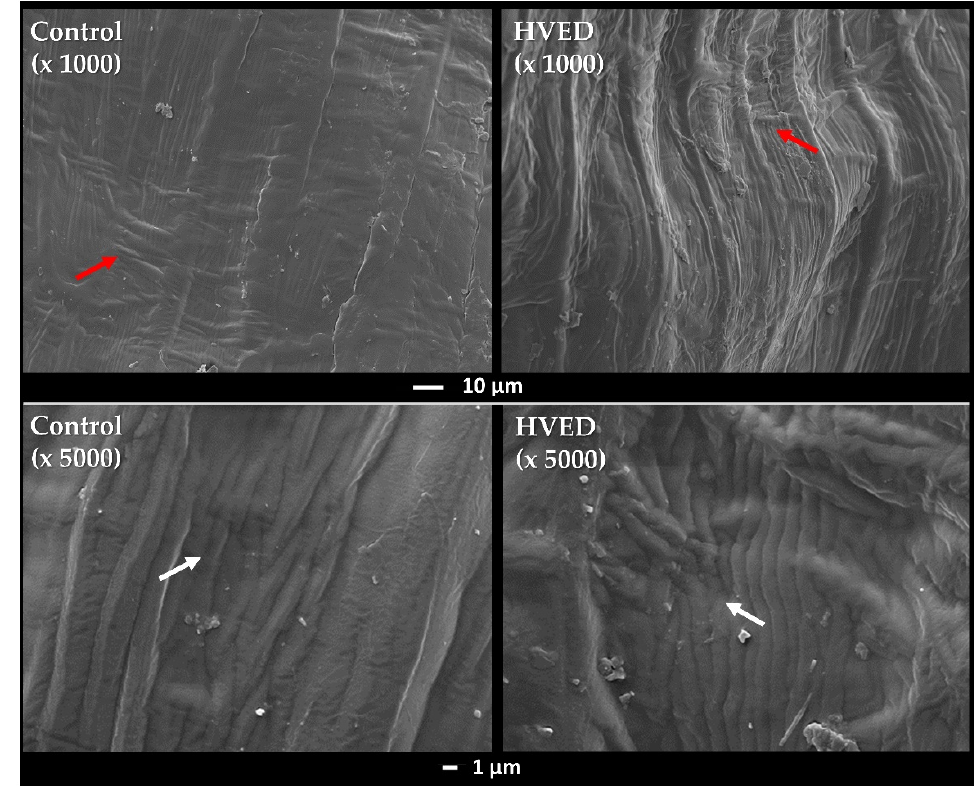
Figure 1. Selected scanning electron microscopy images of the seed morphology recorded at working distance of 10 mm with an acceleration voltage of 5 kV and magnifications of 1000 × and 5000 × . As a result of high voltage electrical discharge treatment (HVED), the number of mesh interconnected structures reduced (red arrows) and the wrinkles become more noticeable (white arrows). Table 1. The impact of high voltage electrical discharge (HVED) on the electrical conductivity of the water medium of wheat seeds. Values are means of three repetitions (50 seeds/repetition) ± S.D. The different letters indicate significances among means of different treatments and between genotypes under same treatment at p < 0.05 using LSD post hoc-test.